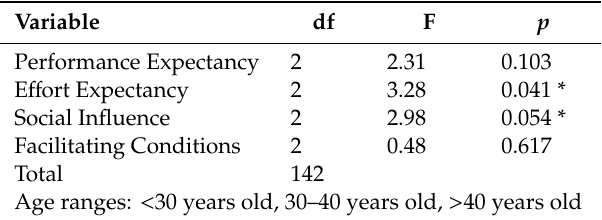
Table 4. Relation between age and individual UTAUT